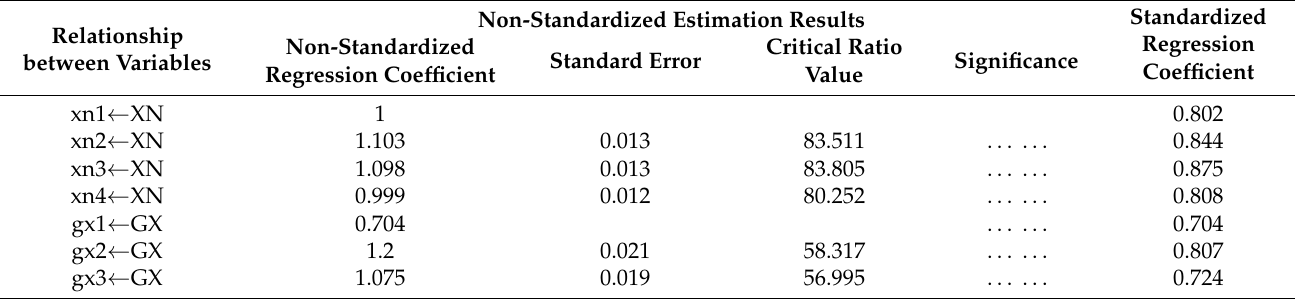
Table 13. Test results of the overall relationship model.